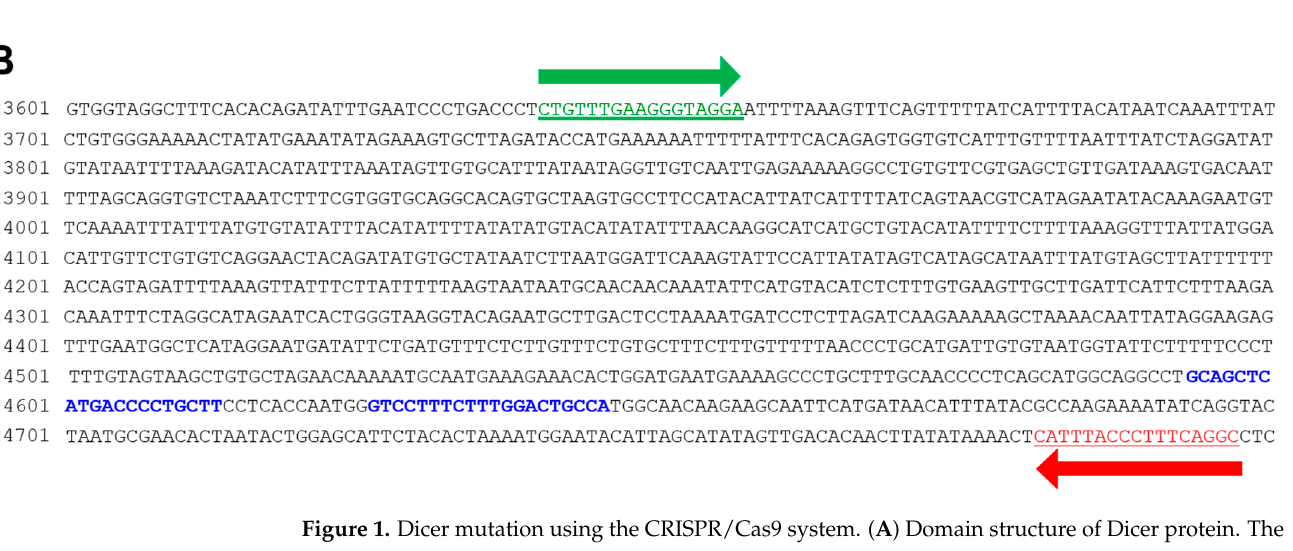
Figure 1. Dicer mutation using the CRISPR/Cas9 system. ( A ) Domain structure of Dicer protein. The small blue rectangle underneath indicates the region corresponding to the gDNA sequence targeted by the CRISPR/Cas9 system. ( B ) Sequence of DICER gDNA. The two sites with blue letters show the sequence targeted by double-nickase CRISPR. Green and red arrows indicate primers for detecting DICER